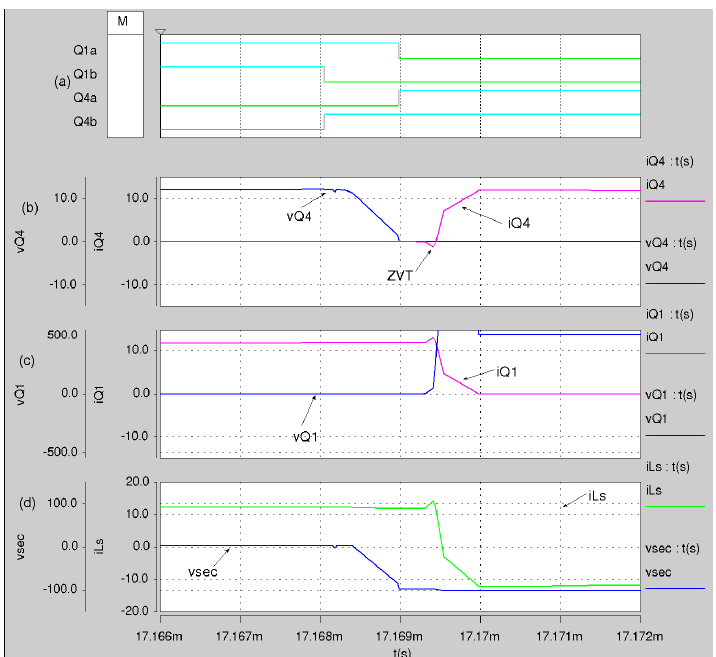
Figure 20. Simulation results to verify ZVT during the switching transition to turn on Q 4 , ( a ) control signals Q 1 a , Q 1 b , Q 4 a , Q 4 b ; ( b ) i Q 4 and v Q 4 ; ( c ) i Q 1 and v Q 1 ; and ( d ) v sec and i Ls . Supply: 127 V, 60 Hz, Output: 100 V, 5 kW.